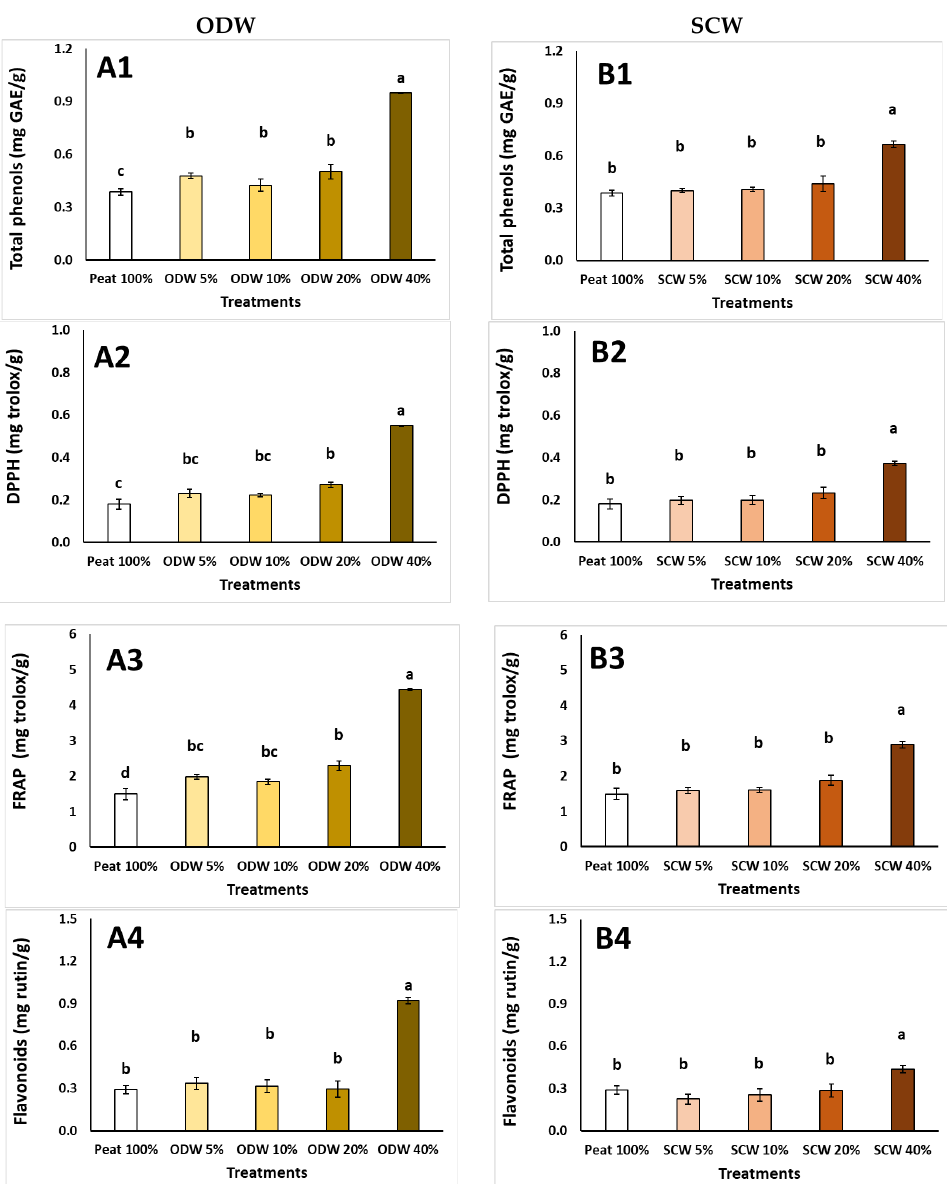
Figure 1. Effect of growing media (peat, Origanum dubium waste — ODW, Sideritis cypria waste — SCW) on total phenolic compound content (mg GAE/g fw), antioxidant activity (DPPH, FRAP: mg Trolox/g fw), and flavonoid content (mg rutin/g fw) of purslane plants (ODW: A1 – A4 ; SCW: B1 – B4 ). Values are means ± SE ( n = 6). Mean values followed by the same letter do not differ significantly at p ≥ 0.05 according to Duncan’s multiple range test.